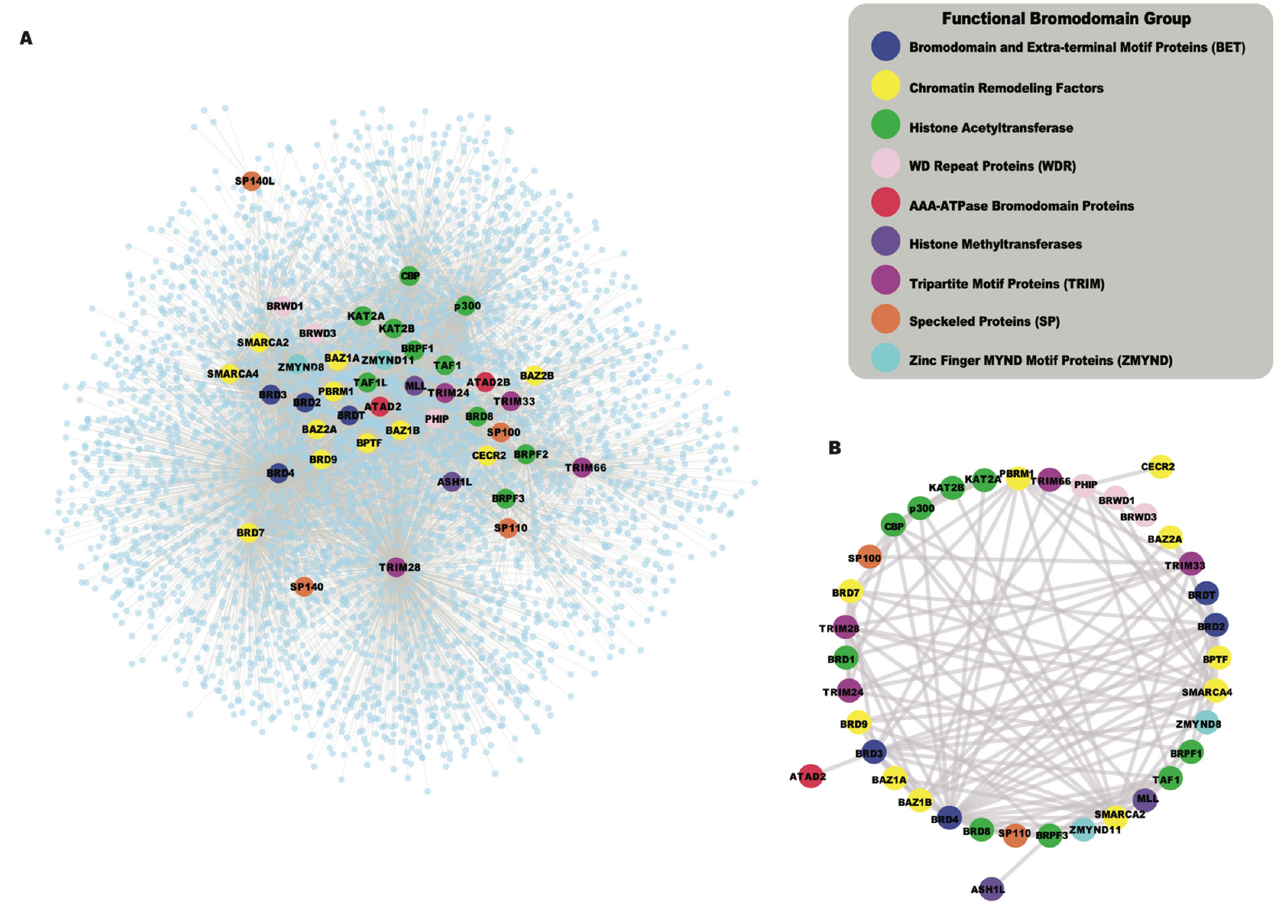
Figure 4. A highly connected functional bromodomain protein-protein interaction (PPI) network. ( A ) Interaction network of bromodomain-containing proteins. The public PPI datasets contain curated PPI derived from a range of affinity purification approaches including affinity capture followed by mass spectrometry (MS), as well as proximity labelling and MS, yeast two-hybrid methods, and others [91]. Accordingly, all physical interactions for the 42 bromodomain-containing genes were processed and plotted with Cytoscape. Each of the bromodomain-containing proteins are displayed in a larger